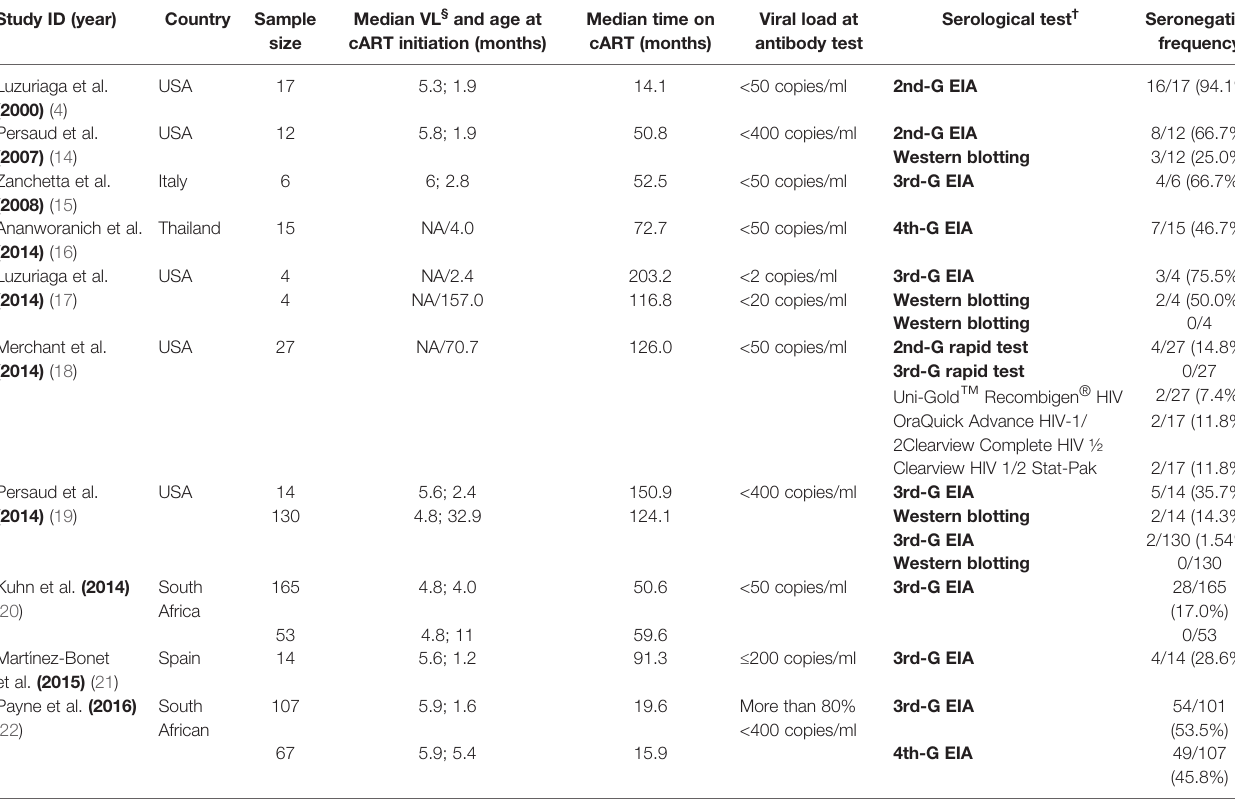
TABLE 1 | Estimated frequency of HIV-1 seronegativity at or after 16 months of age in cART-treated vertically HIV-1-infected